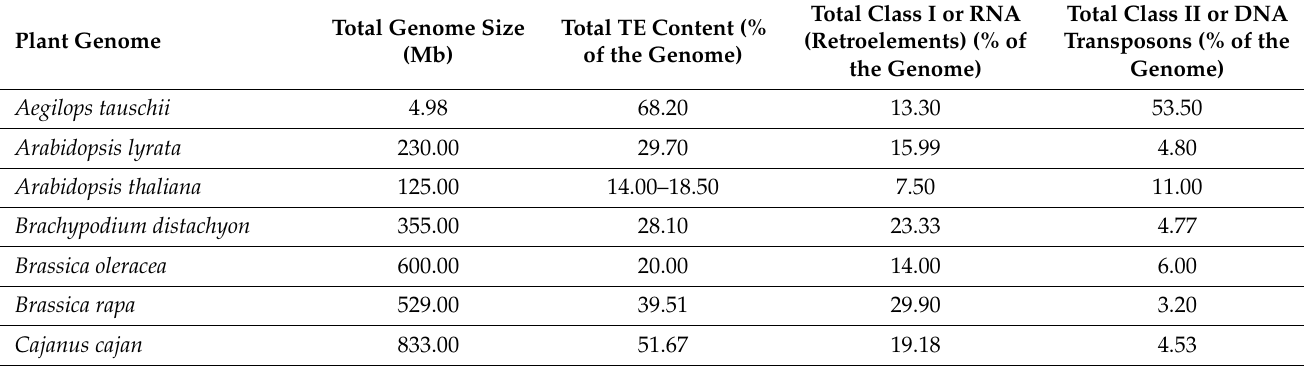
Table 2. Proportion of class I and class II transposable elements (TEs) in the total genome of different plant species [99– 102,104,110,113–129]. The table was adapted and recreated from Ragupathy et al. [99], with copyright permission from the Licensor Elsevier (Trends in Plant Science: Cell Press publisher) and Copyright Clearance Center (https://www.copyright. com) (Supplementary File